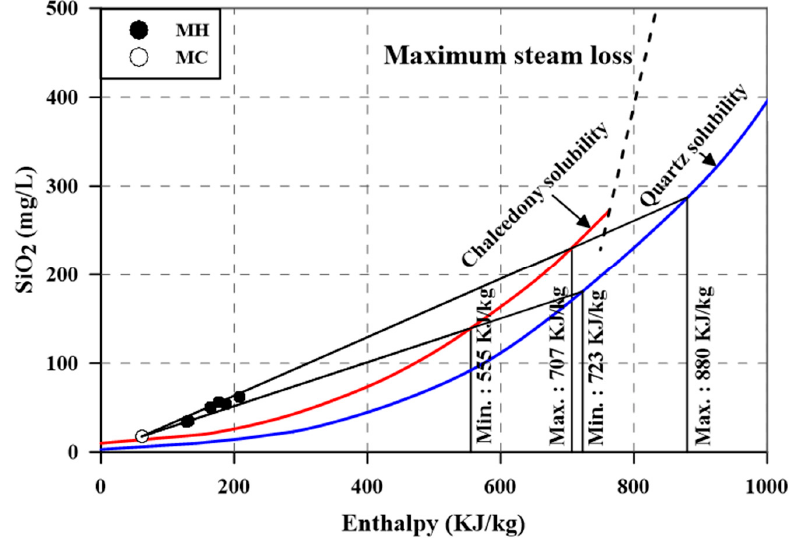
Figure 13. Enthalpy–silica mixing diagram of thermal waters (filled circles) and cold shallow water (open circle) in the Magumsan area. Table 6. Estimated reservoir temperatures of thermal waters and their mixing ratio with cold water based on the mixing model of enthalpy and silica.